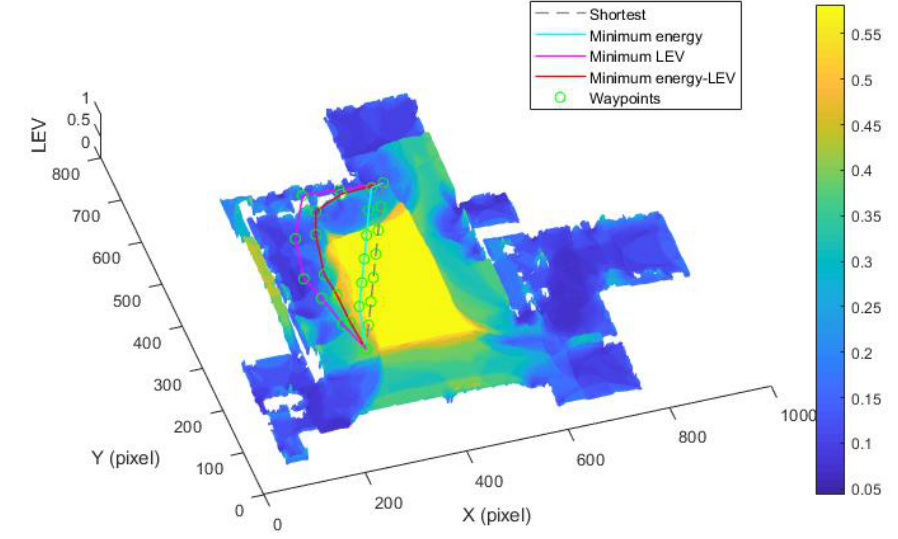
Figure 21. Comparison of trajectories of the case (2).